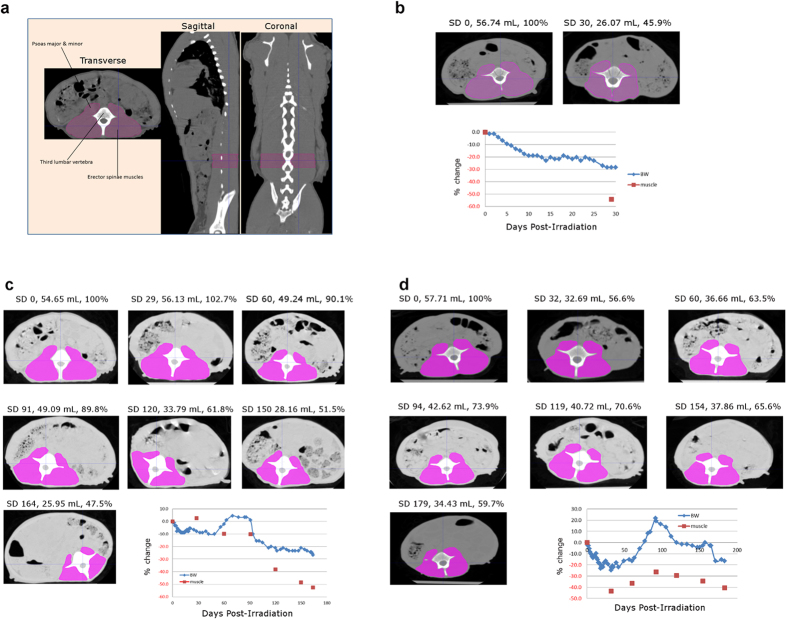
Quantification of skeletal muscle mass using CT imaging.(a) Demarcation of skeletal muscle tissues at the 3rd lumbar vertebra. The muscles in this area include the psoas major & minor muscle, and erector spinae muscles. The region was shown by the pink color in three different views. (b) CT images of skeletal muscle at the 3rd lumbar vertebra in a NHP exposed to 10 Gy PBI/BM5 which was euthanized on d 30. (c) CT images of skeletal muscle at the 3rd lumbar vertebra in a NHP exposed to 10 Gy PBI/BM5 which was euthanized on d 164 after radiation exposure. (d) CT images of skeletal muscle at 3rd lumbar vertebra in a NHP exposed to 11 Gy PBI/BM5. This NHP survived the 180 d study after radiation exposure. A graph showing the time course of body weight and skeletal muscle change is included for each NHP. Blue line, body weight change; red line, skeletal muscle change.